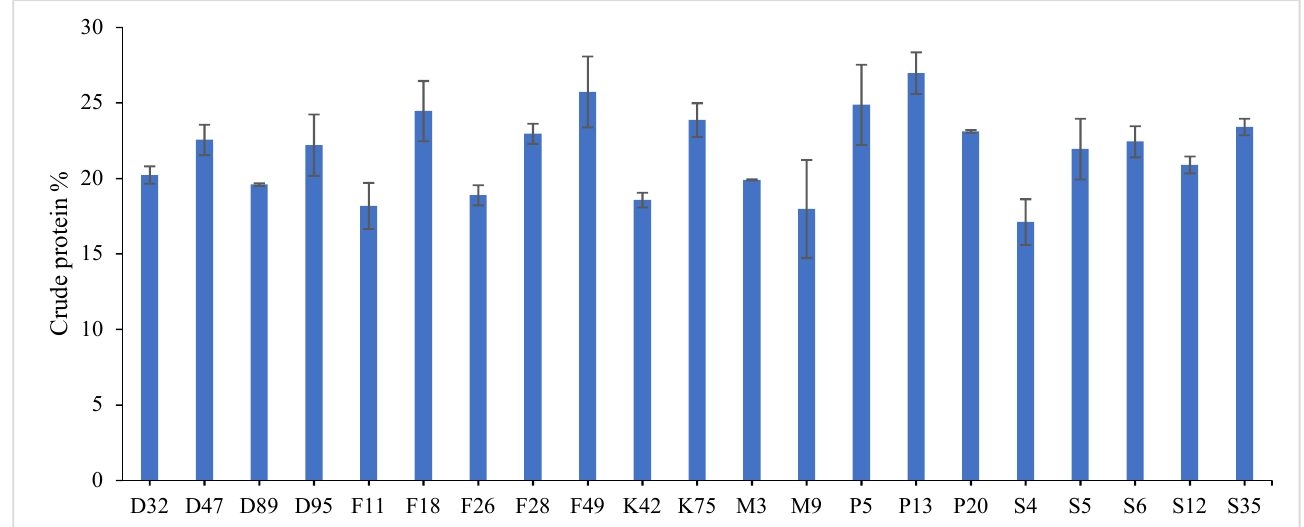
Figure 6. Mean performance of crude protein % of twenty-one alfalfa genotypes in the first year. Bar represents the standard deviation.